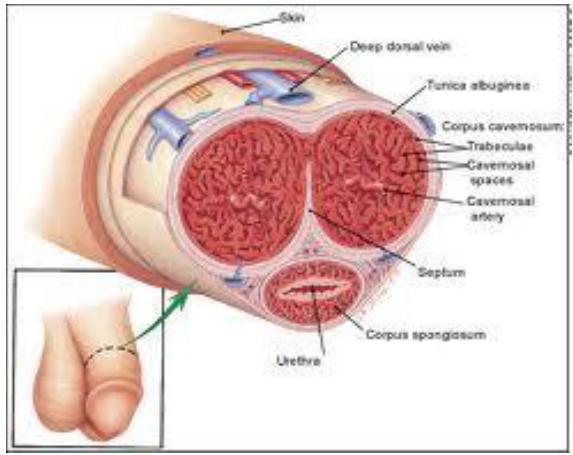
Figure 3: Cross section of the penis, demonstrating corporal bodies, penile fascia, vessels, and nerves. (14) In 2009, Snodgrass and Prieto recommended that ventral curvature may resolve with ventral degloving and dartos dissection, the ventral curvature less than or equal to 30 degrees remaining after ventral dissection can be corrected by midline dorsal plication. Ventral curvature greater than or equal to 30 degrees after ventral dissection can be straightened by either single ventral corporeal incision with grafting or multiple ventral corporeal incisions without grafting. During these maneuvers the urethral plate and adjacent corpus spongiosum often can be maintained intact by elevating them from the corpora. Persistent ventral curvature after these maneuvers requires urethral plate transection.